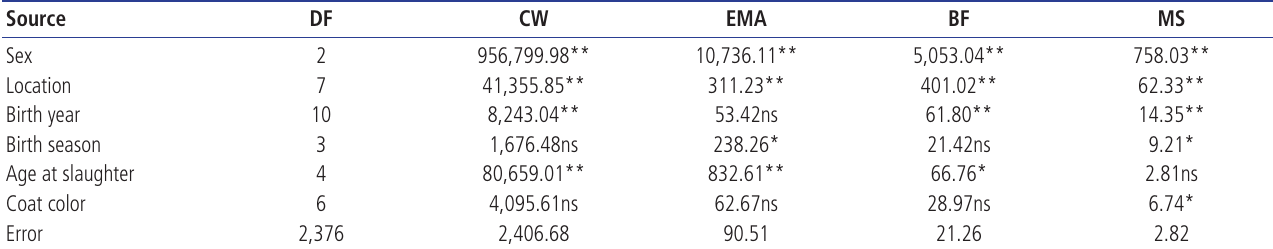
Table 4. Analysis of variances of the carcass traits Source